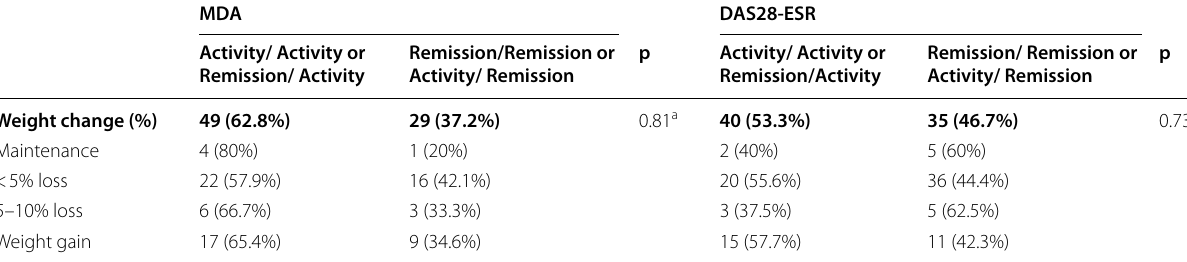
Bold indicates p statistically significant (